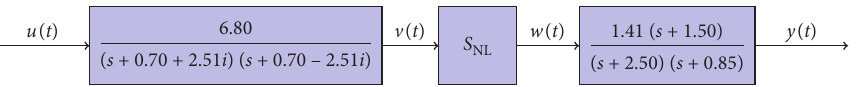
Figure 16: Numerical example 3: Wiener–Hammerstein structure. Table 6: Ranking of estimated linear models for numerical example 3 (Wiener–Hammerstein system). Models 4 p , 1 z /5 p , and 2 z /5 p have been excluded due to high MDL